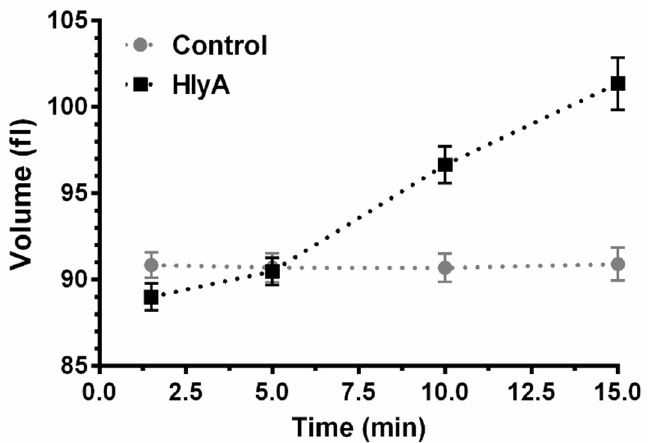
Figure 1. RBCs at 10% hematocrit were incubated in the absence of toxin (Control), or in the presence of 100 ng/mL HlyA (HlyA) at 37 °C during the times indicated in the figure. Then, MCV was measured by impedance cell cytometry, as indicated in Section 4.9. Points represent the mean values and error bars represent standard error of the mean (S.E.M.). (Control, N = 20; HlyA, N = 15). In the absence of HlyA (i.e., control), MCV was roughly constant. Exposure to the toxin led to a slight reduction in MCV after 1.5 min, followed by continuous